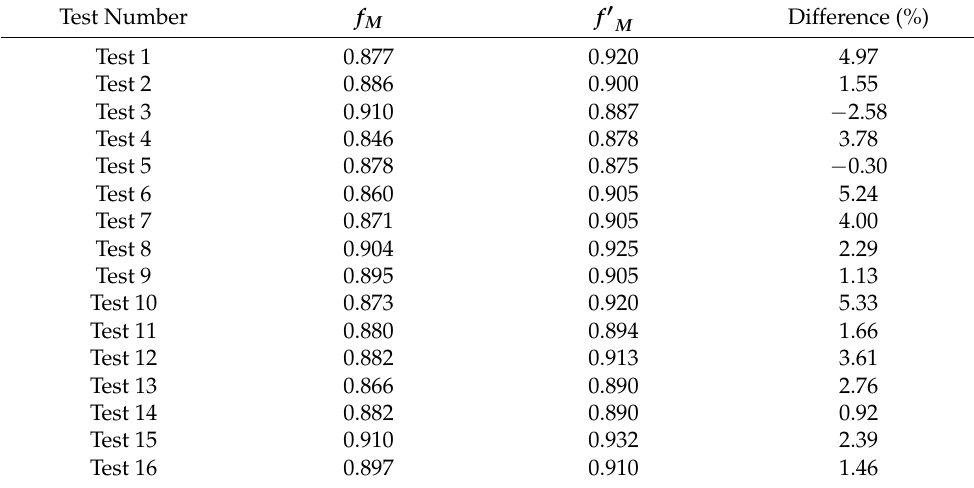
Table 13. Comparison between the reduction factors of moment stiffness from fitted expressions and finite element